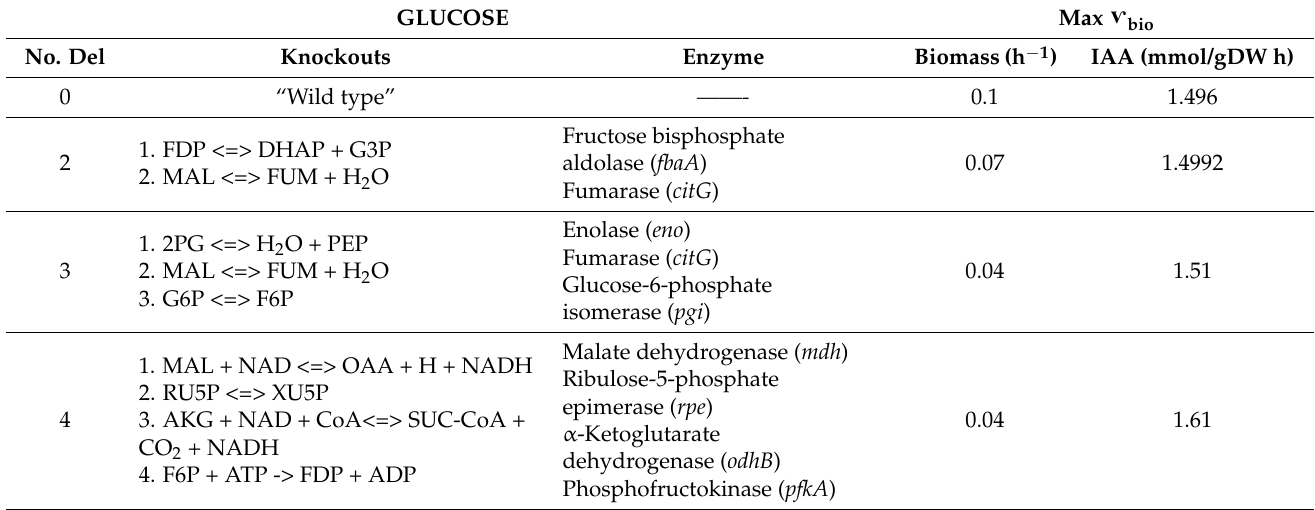
Table 2. Sets of candidate reactions to be deleted with potential increase in the production of IAA while maintaining optimal biomass production.